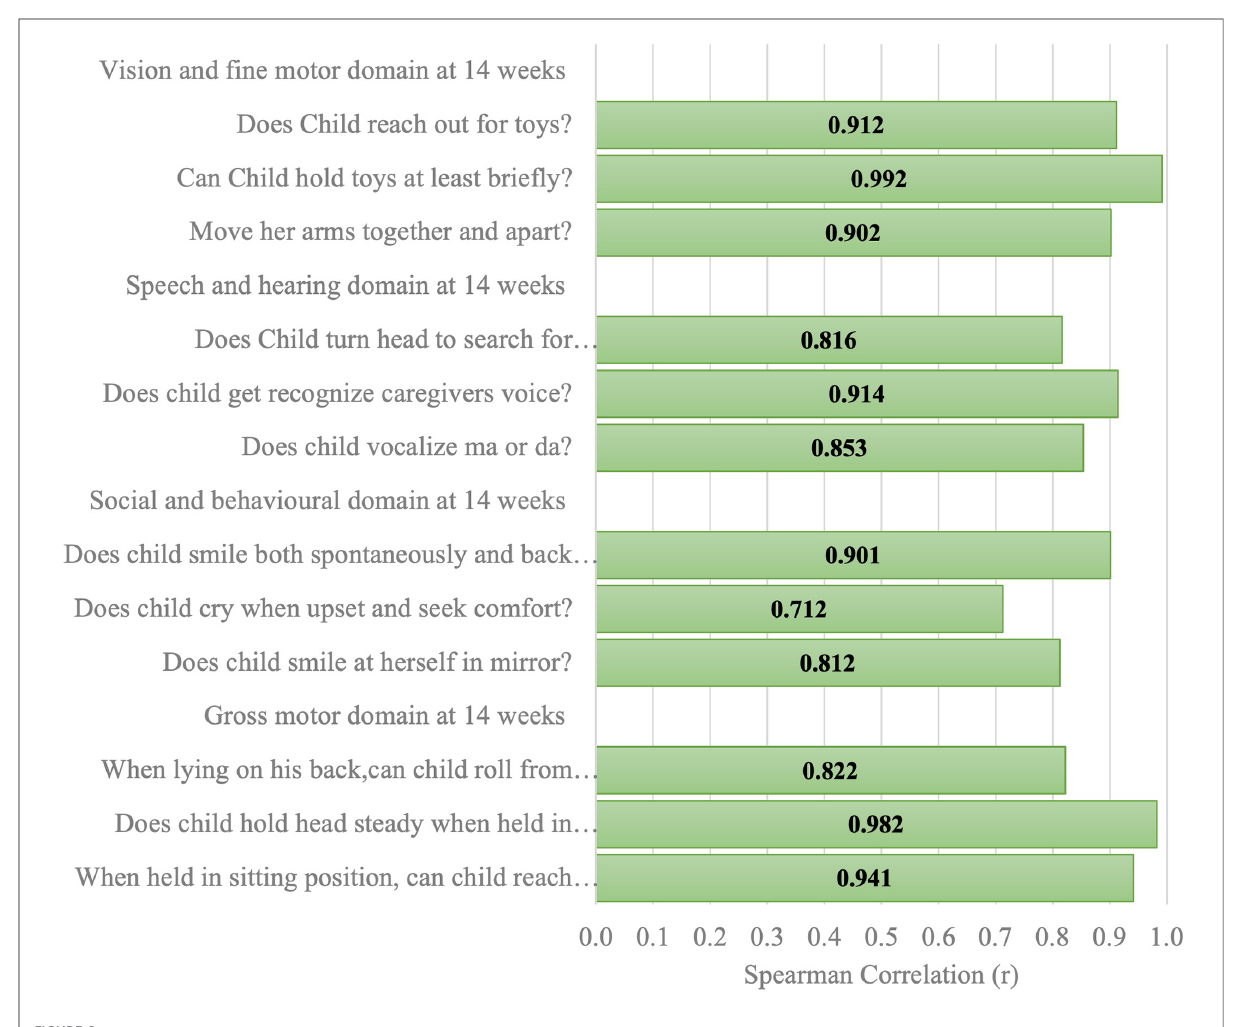
FIGURE 8 Spearman correlation coef fi cient of the ISDS scores of two assessors of the same participants aged 14